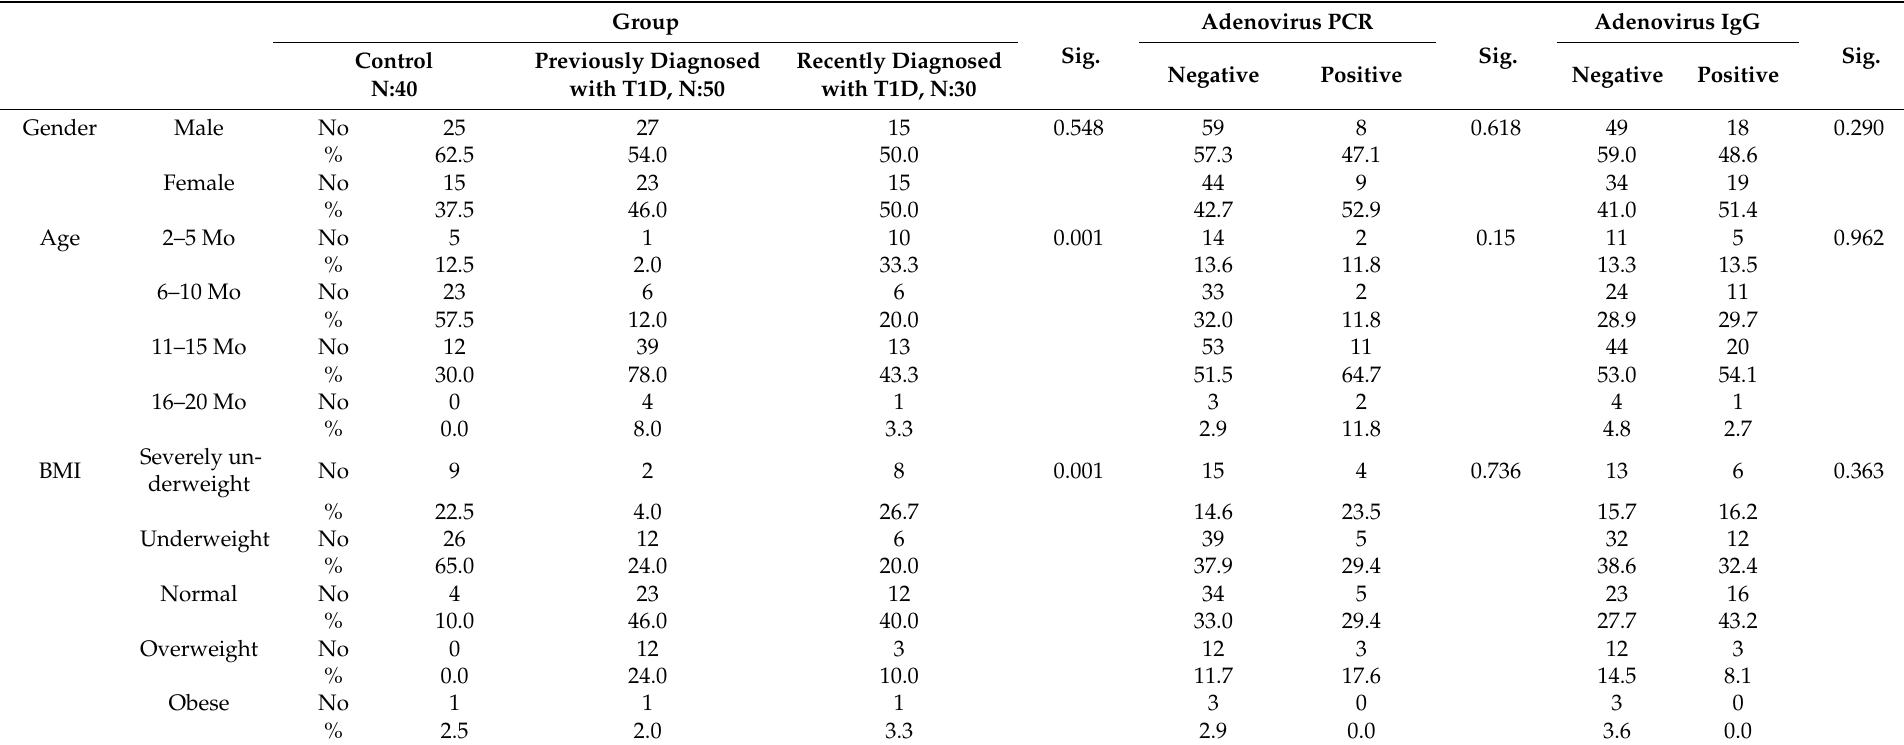
Table 1. Demographic data of healthy controls, recently diagnosed T1DM, and previously diagnosed T1D children expressed as numbers and percentages. Group Adenovirus PCR Sig.